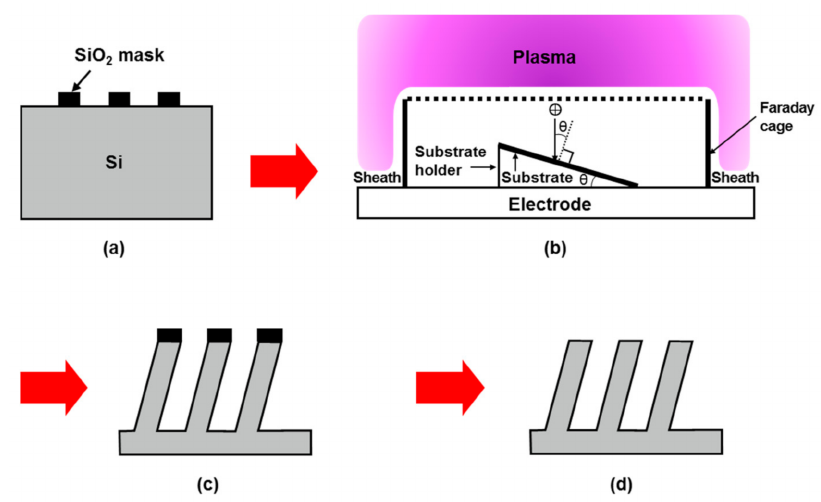
Figure 1. Schematic of the fabrication process of periodically arrayed oblique Si nanopillars: ( a ) Si substrate with hole patterns and a SiO 2 mask; ( b ) slanted plasma etching using a Faraday cage system; ( c ) oblique etch structures formed after the slanted plasma etching; ( d ) oblique Si nanopillars formed following removal of the SiO 2 mask.